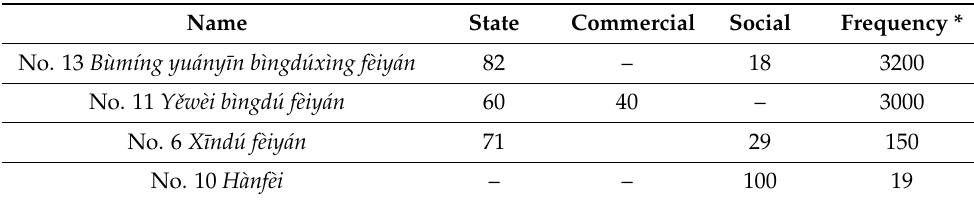
Table 5. Frequency and percentage distribution of the remaining four terms used by state, commercial, and social